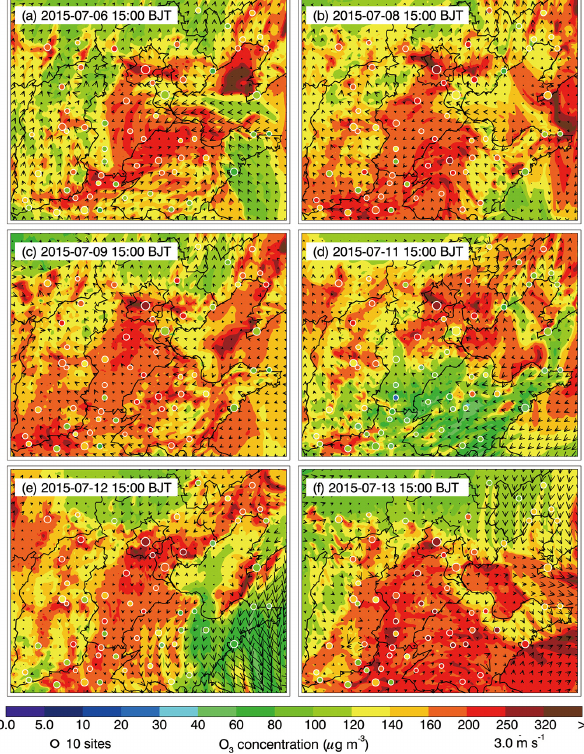
Figure 7. Same as Fig. 6, but for O 3 at